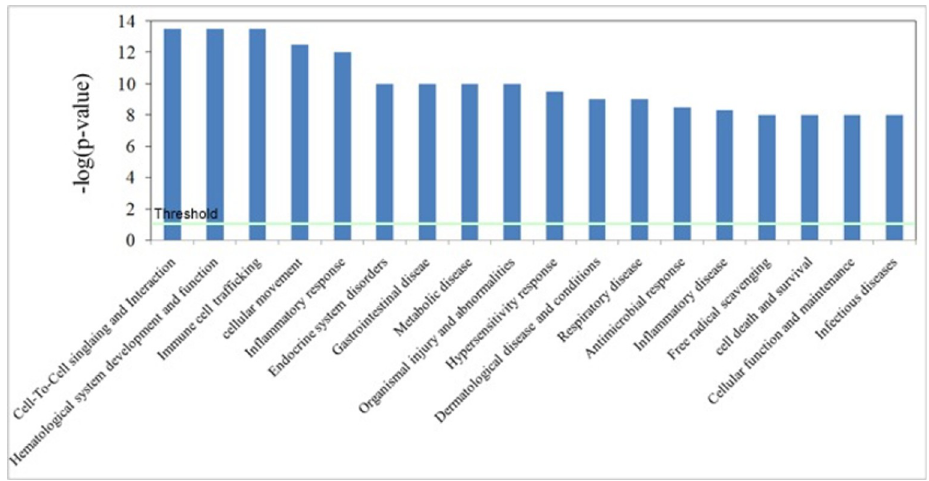
Fig 4. Functions of proteins or genes associated with infection. List of functions (or disease) associated with the differentially expression proteins/genes which are associated with